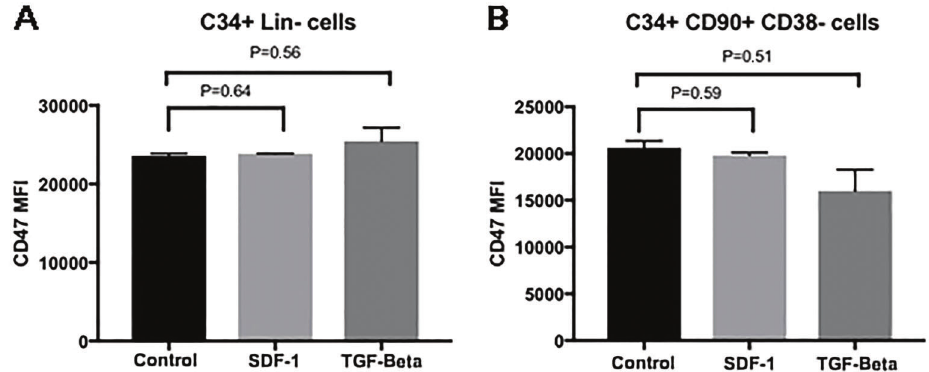
Figure 5. CD47 expression after exposure to SDF-1 and TGF- (cid:1) . A , Comparison in CD34 positive cells and B , Hematopoietic stem cells (Welch-corrected Student ’ s t -test). Data are reported as mean ± SD. MFI: mean fl uorescence